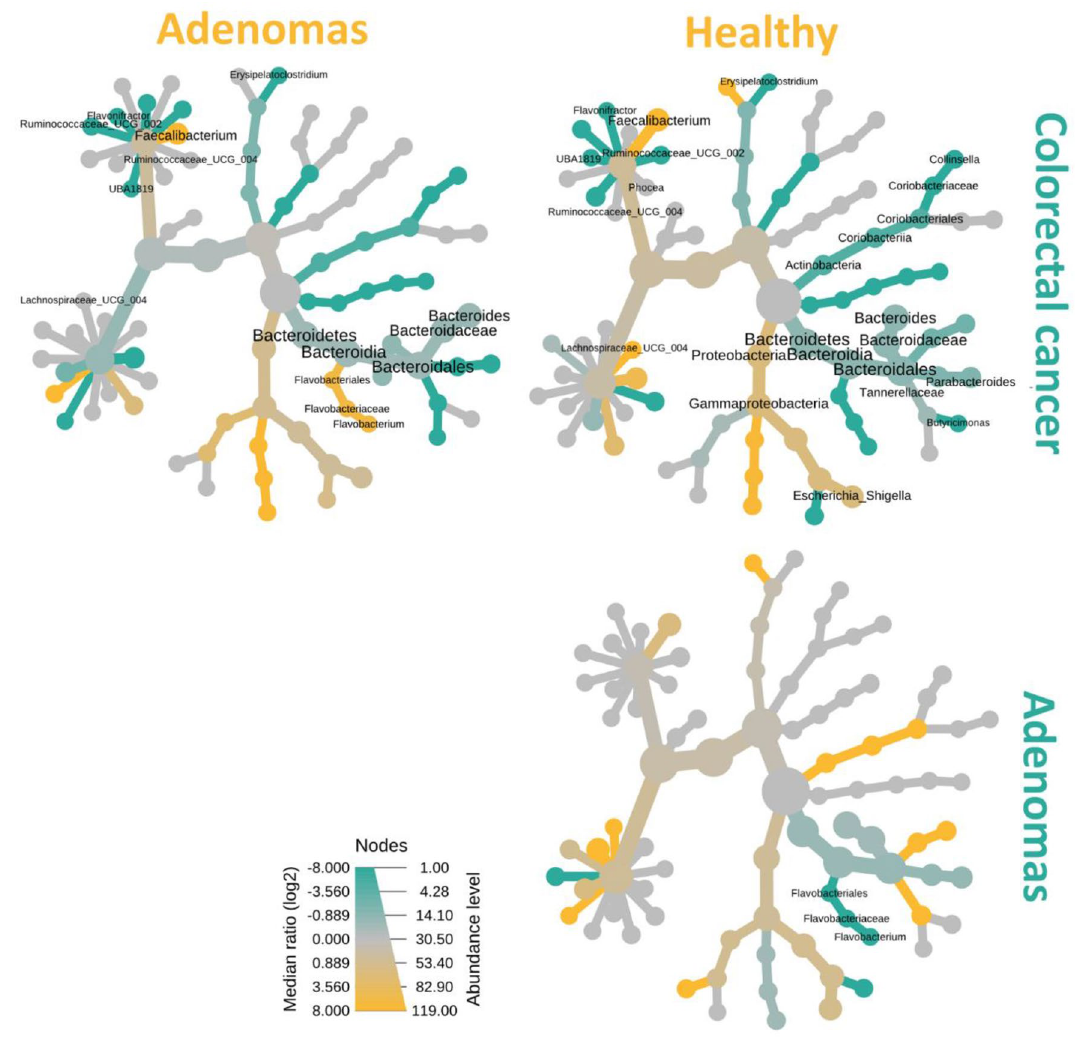
Figure 2. Heat tree analysis illustrating the taxonomic alterations in the mucosal microbiota composition according to adenoma–carcinoma sequence based on the log2 ratio median abundance. Significant alterations of taxa are displayed by name at the corresponding node. The nodes indicate the hierarchical structure of taxa. Three comparisons were conducted: colorectal cancer (CRC) (green) vs healthy control (HC) (yellow); CRC (green) vs adenoma (AD) (yellow); and AD (green) vs HC (yellow). The dominant color corresponds to a higher number of amplicon sequence variants (ASVs). The Log2 ratio is 0 (gray) when the compared groups are not significantly